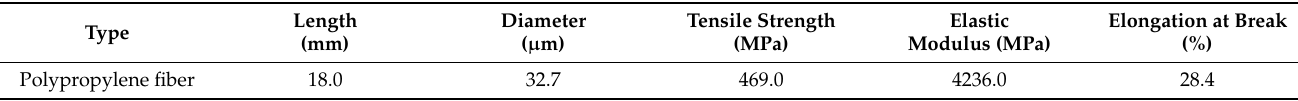
Figure 2. Polypropylene fiber. Table 2. Basic parameters of polypropylene fibers.